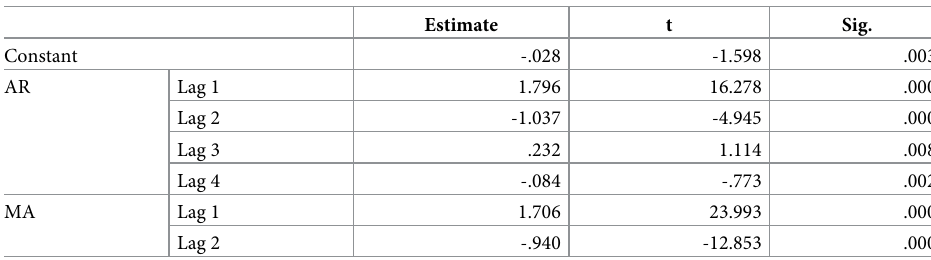
Table 3. ARIMA model